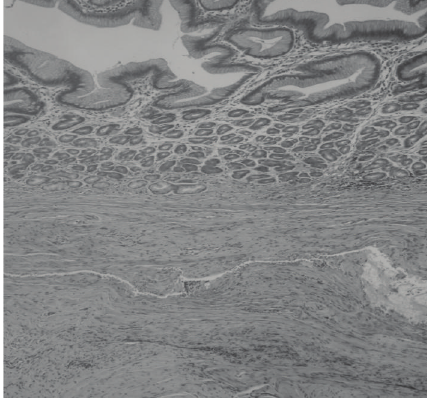
Figure 2: Umbilical cyst lined by ectopic gastric